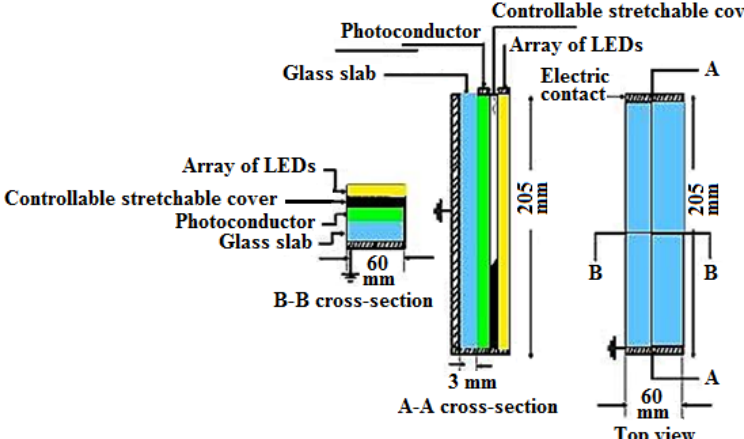
Figure 4. Overview of cross-sections in the slab responsible for stimulating the spectral phases to be in phase at any desired location.